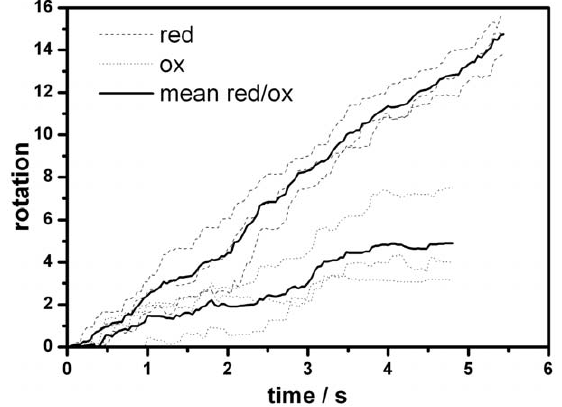
Figure 3. SDS-gel of the mutant GH54 under rotation assay conditions. Two samples of GH54 were oxidized (ox.) with 4 mM or 8 mM DTNB for 12 minutes, and afterwards re-reduced (re-red.) with 20 mM DTT for 12 minutes, to simulate the conditions in the rotation assay.